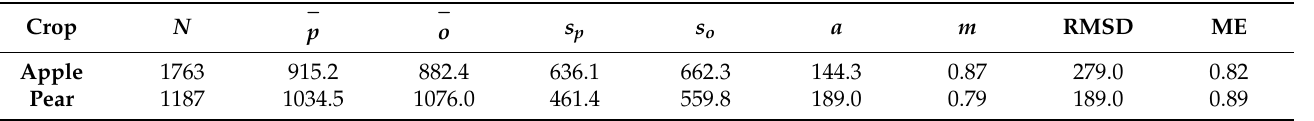
Table 3. Statistics of regression analysis of predicted versus observed instantaneous PAR-transmission values in apple and pear orchards 1